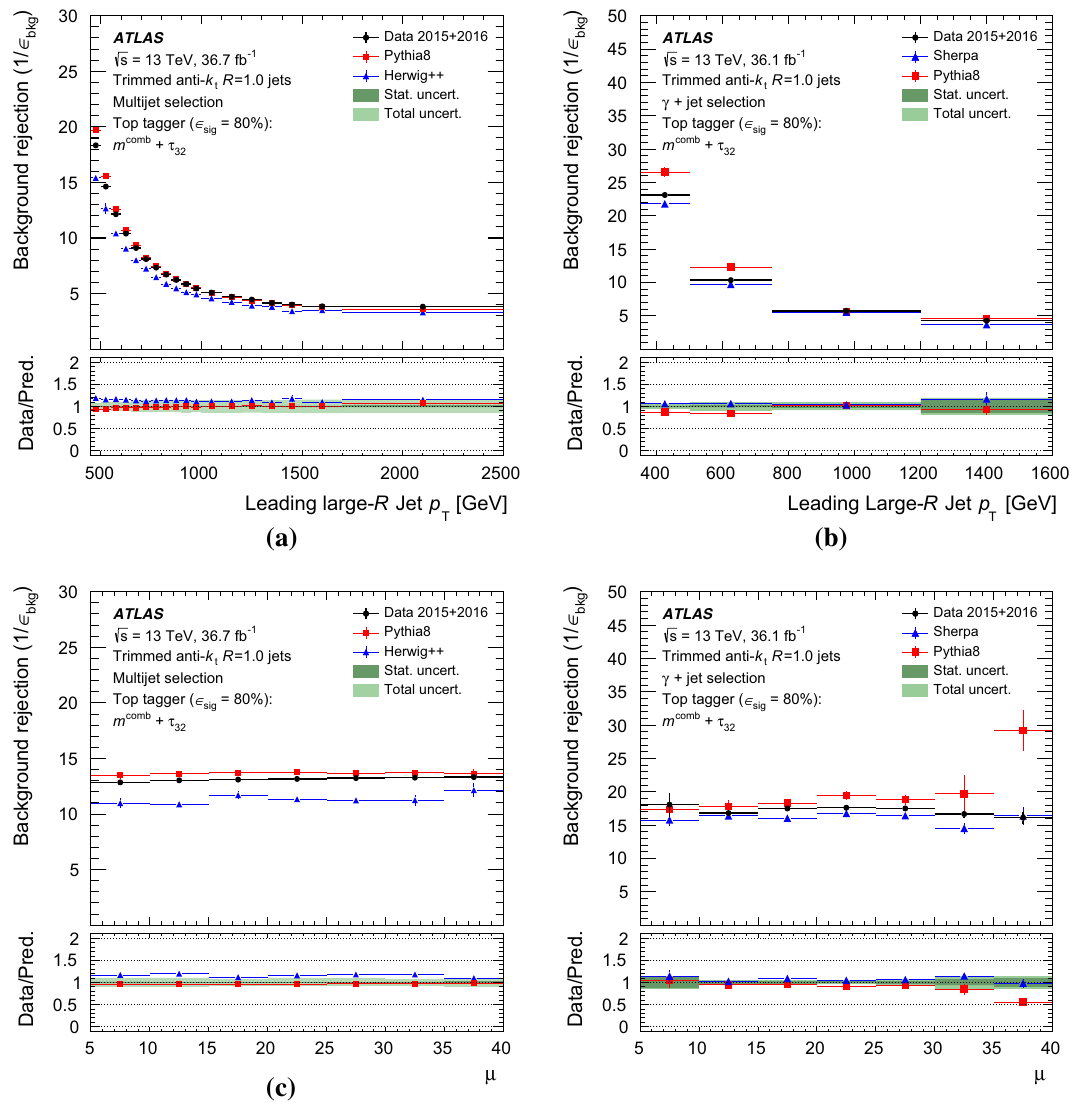
Fig. 35 The estimated light-jet rejection 1 /(cid:12) bkg as a function of the leading jet p T and the average number of interactions per bunch crossing μ for the two-variable top-quark tagger in the multijet ( a , c ) and γ + jet ( b , d ) selection